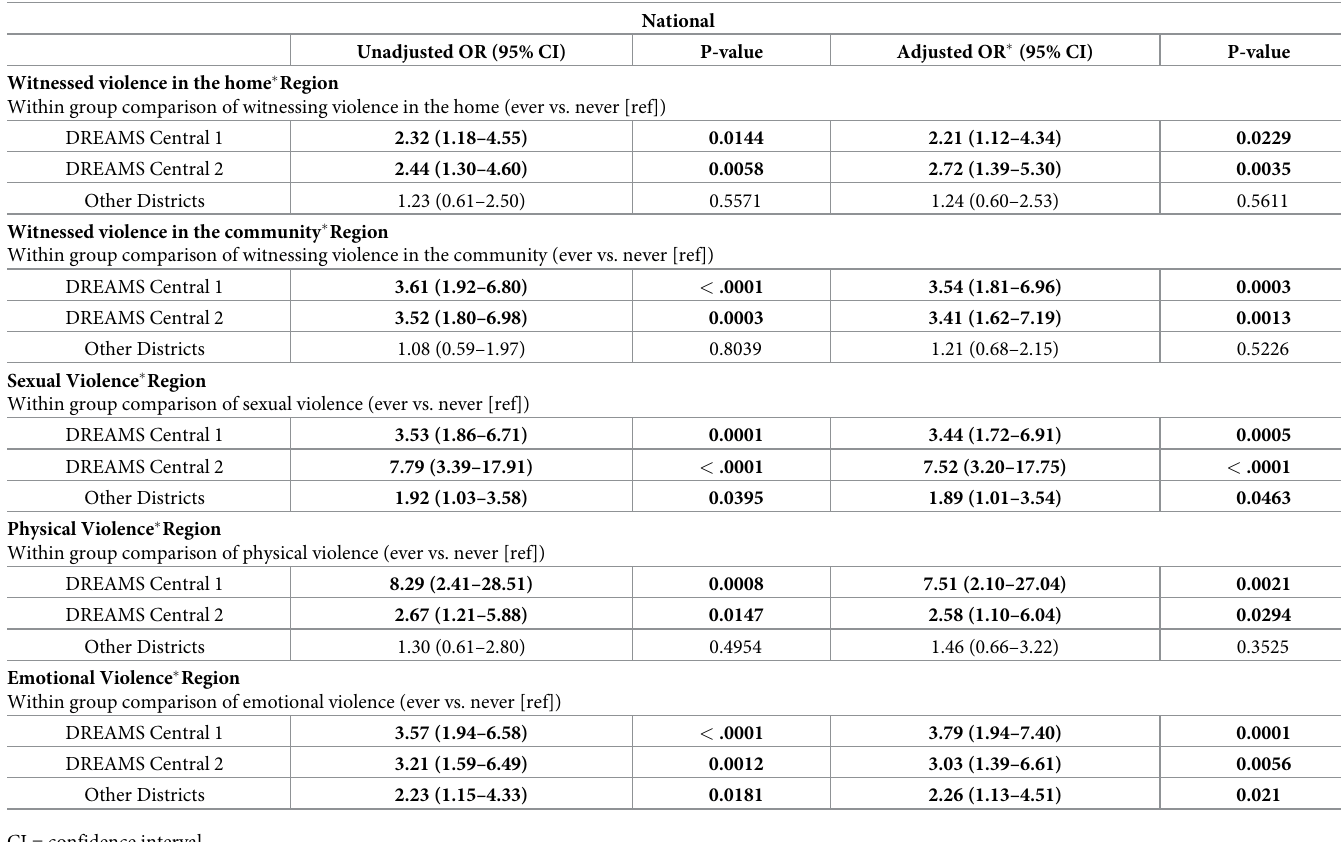
Table 5. Interactions between violence and violence-related experiences, and geographic region and recent transactional sex a among sexually active b Ugandan girls and young women age 13–24 years